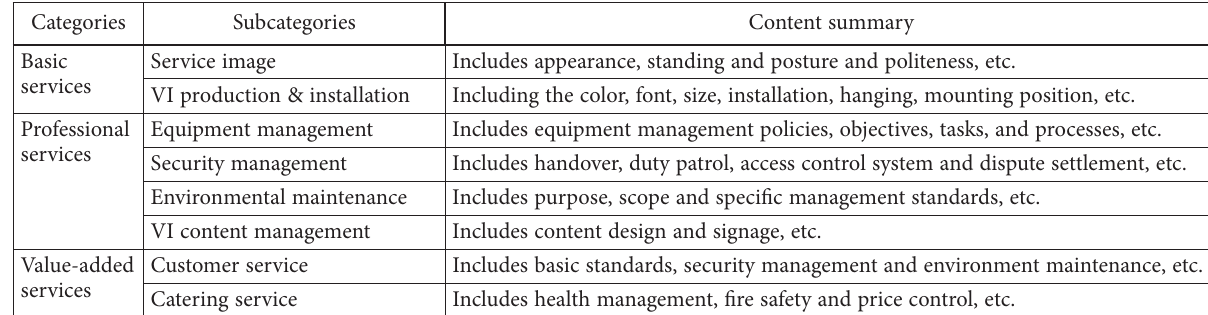
Table 2. Classification of property service quality specifications